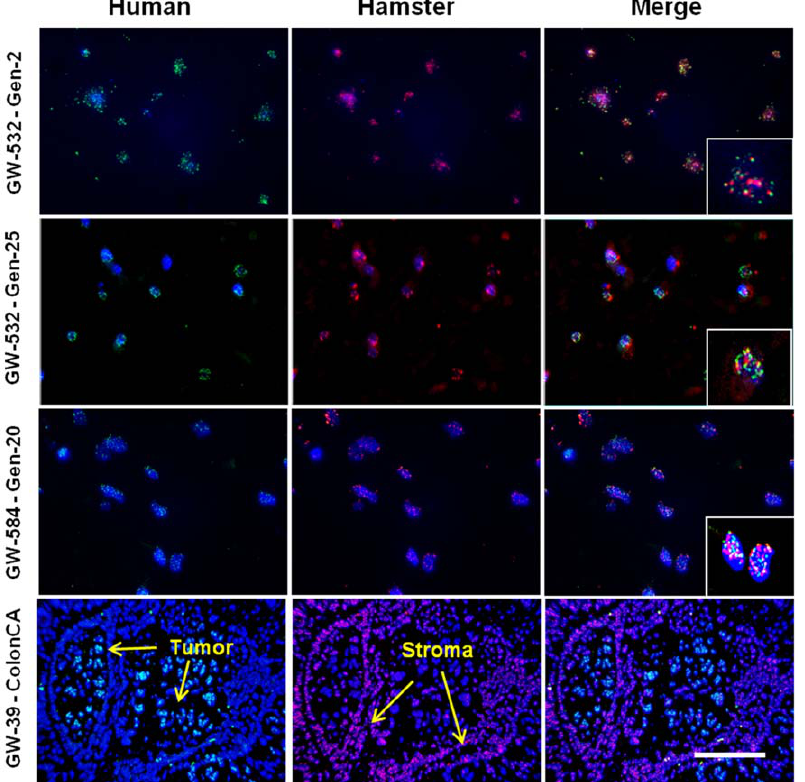
Figure 4. FISH of GW-532, early and late generations, and GW-584 late generation tumor cells was performed with the human (green) and golden hamster (red) pancentromeric probes to evaluate the co-existence of species-specific genomic material within these cells. A human colon carcinoma (GW-39) grown in the hamster cheek pouch served as a positive control. Within the GW-532 and GW-584 tumor cells, the hamster (red) and human (green) probes are identified in most cells and co-localized to the same cells (photoshop composite). On the other hand, human and hamster chromosomes show distinct, cell-specific localization within the human colon carcinoma xenograft, with hamster stromal tissue, and human colon carcinoma cells identified. DAPI background staining was performed on all tissues to identify the nuclei. Scale bar in the lower right corner corresponds to 100 m m for all GW-532 and GW-584 images and 67 m m for all of the higher magnification insets. For the GW-39 images, the scale bar corresponds to 200 m m.